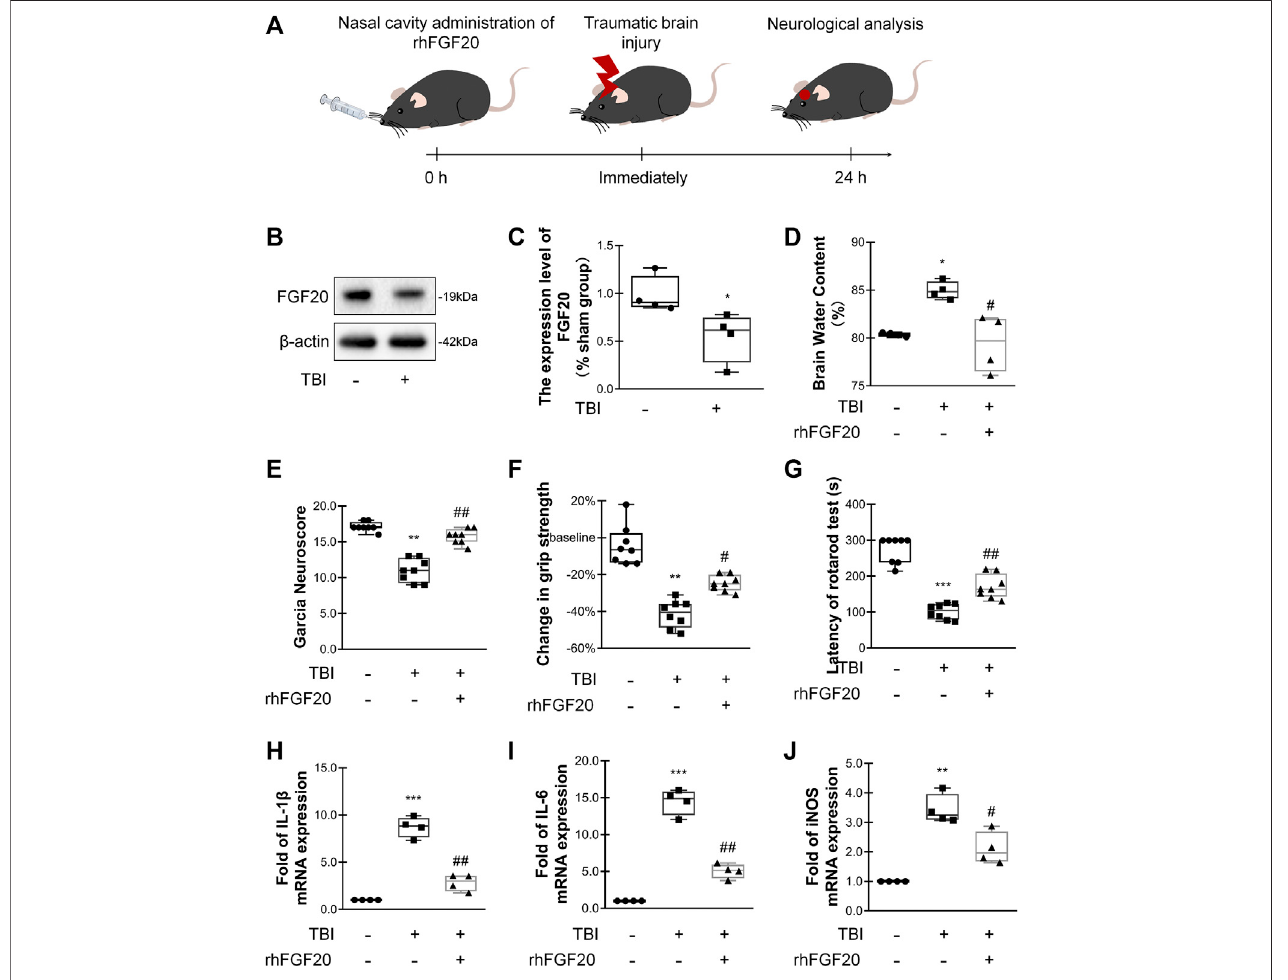
FIGURE 1 | Exogenous rhFGF20 improved neurofunctional de fi cits and behavioral recovery in TBI mice (A) A schematic diagram showing the in vivo experimental protocol (B) Representative image of western blot analysis of endogenous FGF20 in the sham and TBI groups (C) Quanti fi cation of western blot data for endogenous FGF20 ( n (cid:1) 4) (D) EffectsofrhFGF20onbrainwatercontentat24 hafterTBI( n (cid:1) 4) (E) EffectsofrhFGF20assessedbytheGarciatestat24 hafter TBI( n (cid:1) 8) (F) Effects of rhFGF20 assessed by the grip strength test 24 h after TBI ( n (cid:1) 8) (G) Effects of rhFGF20 assessed by the rotarod test at 24 h after TBI ( n (cid:1) 8) (H – J) Effects of rhFGF20 on mRNAlevels oftheproin fl ammatory cytokines IL-1 β ,IL-6, and iNOS, with values normalized tothe housekeeping gene β -Actin ( n (cid:1) 4).* p < 0.05, ** p < 0.01, *** p < 0.001 vs. sham group. # p < 0.05, ## p < 0.01 vs. TBI group. Data are presented as the mean values ±